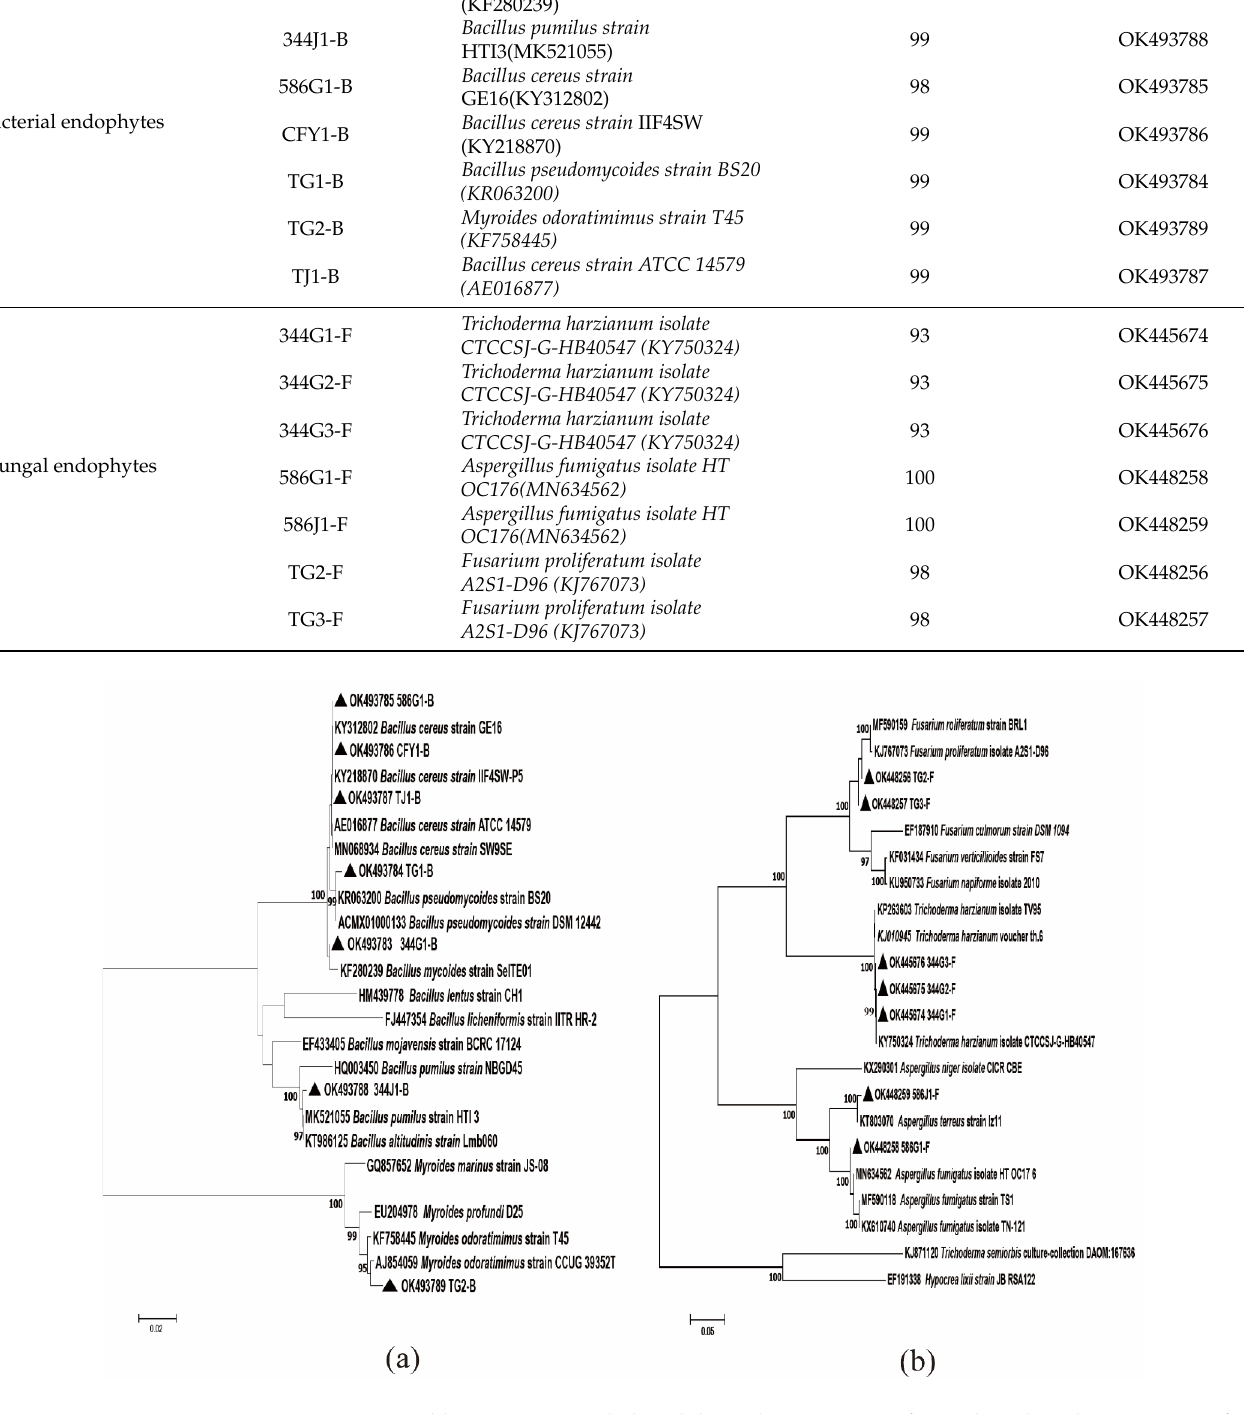
Figure 2. Neighbor-joining tree deduced through MEGA 7.0 software based on the sequences of 16S and ITS rRNA gene of endophytes; ( a ) is endophytic bacteria and ( b ) is endophytic fungi.